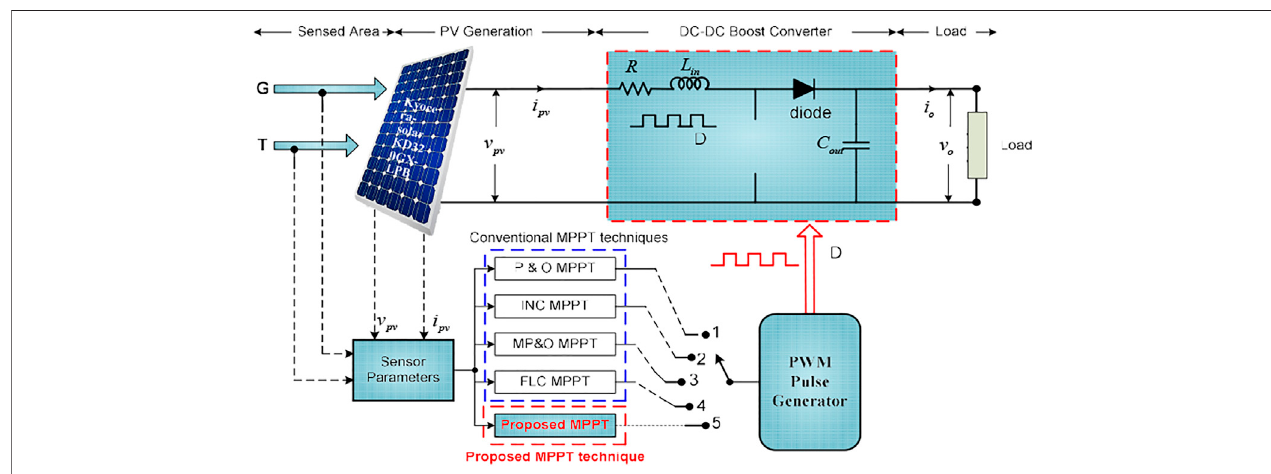
FIGURE 1 | Schematic diagram of PV energy conversion system with various MPPT techniques.